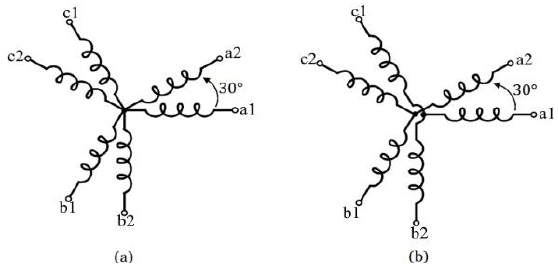
Figure 2. Asymmetrical six-phase stator windings with ( a ) single and ( b ) dual isolated neutral points. The 2L-VSI provides 2 6 = 64 different switching states, defined by six switching functions which correspond to the six inverter legs 𝑆 = [𝑆 𝑎1 ,𝑆 𝑏 𝑆 𝑖 ∈ {0,1} . The following equation may be used to calculate the stator phase voltages as a function of the dc-link voltage and the aforementioned vector [S]: